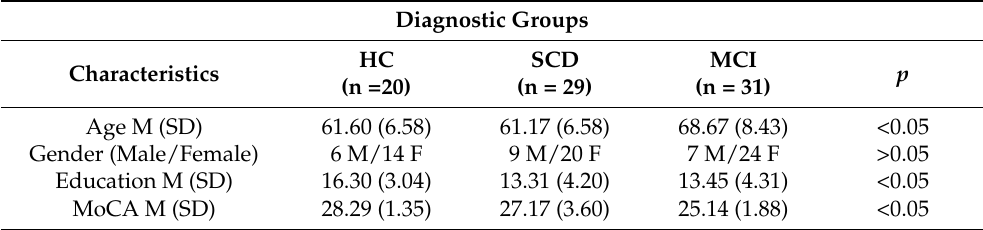
Table 1. Demographic characteristics of the participants of the study (n =